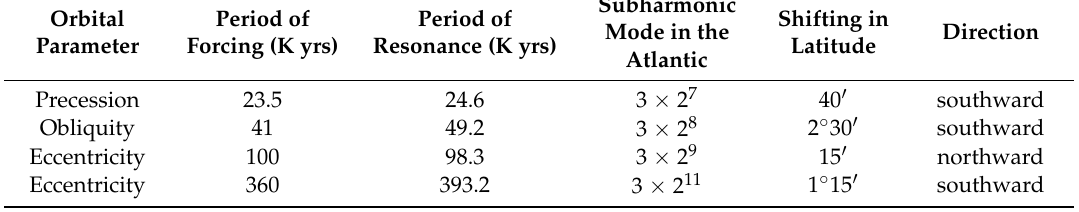
Table 3. The periods of forcing compared to the natural periods of Gyral Rossby Waves (GRWs) and the shifting of the average latitude of the centroids resulting from the tuning. Subharmonic modes in the South Pacific have to be divided by 2. In the South Indian Ocean, they have to be multiplied by 3/2.